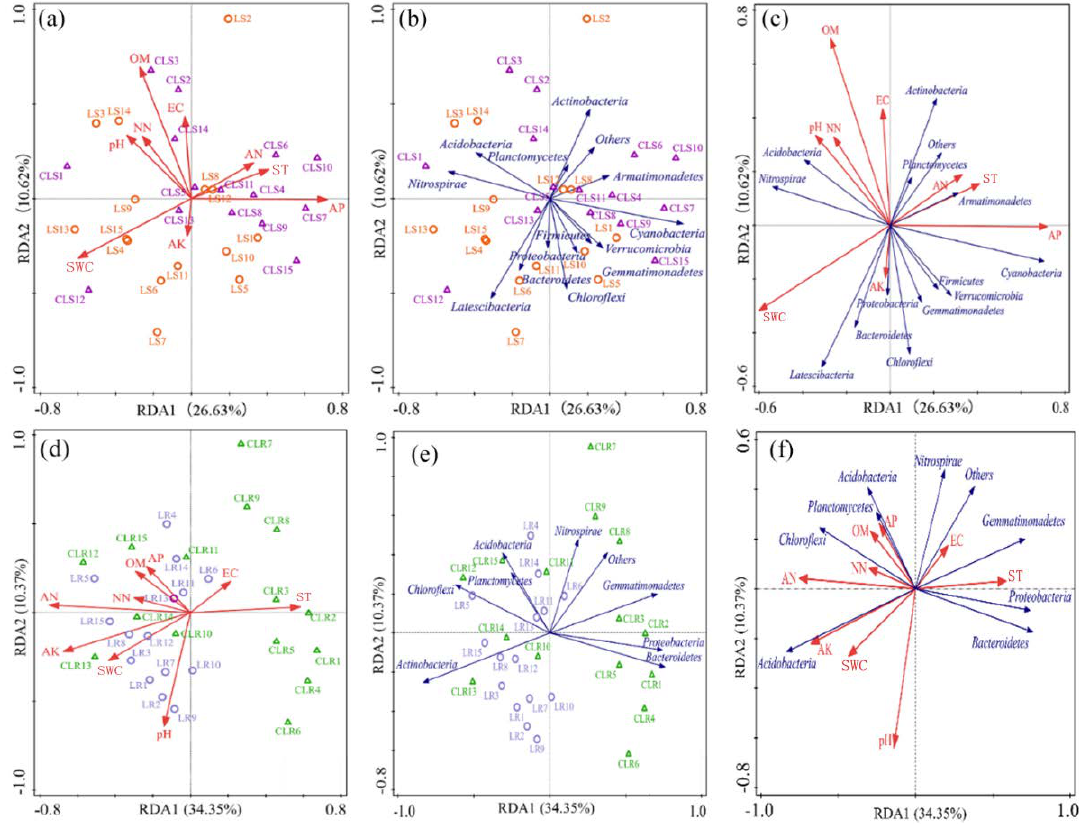
Figure 6. RDA analysis of samples and environmental factors ( a , d ), samples and major phyla ( b , e ), and environmental factors and major phyla ( c , f ). ( a – c ) represent RDA analysis of mining subsidence area and its control area in the Daliuta Coal Mine. ( d – f ) represent RDA analysis of vegetation rehabilitation area and its control area in the Heidaigou Coal